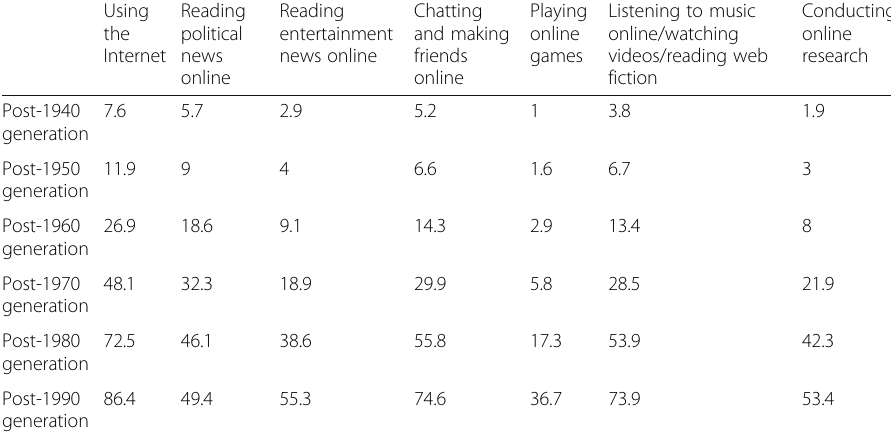
Table 2 Generational disparities in internet usage: proportion of people doing the following things every day or multiple times a week (%) Using the